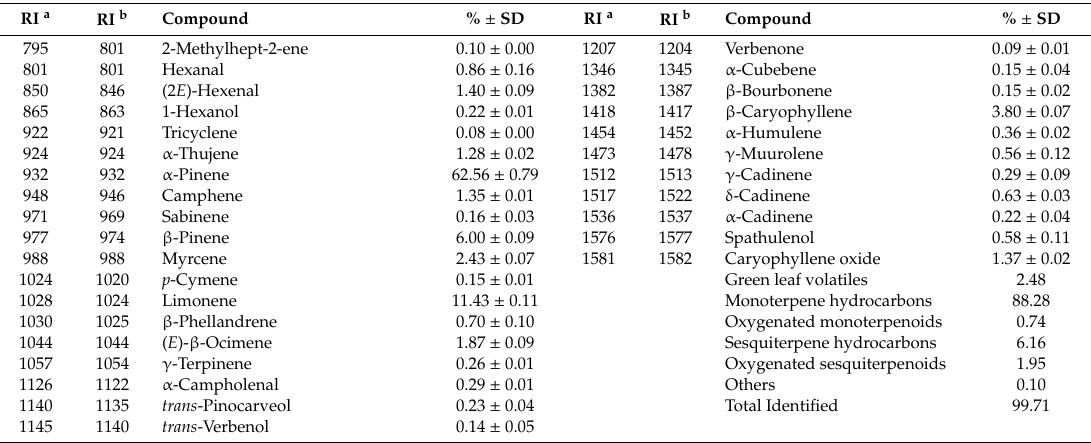
Table 8. Chemical composition of the essential oil of Smallanthus uvedalia (L.)